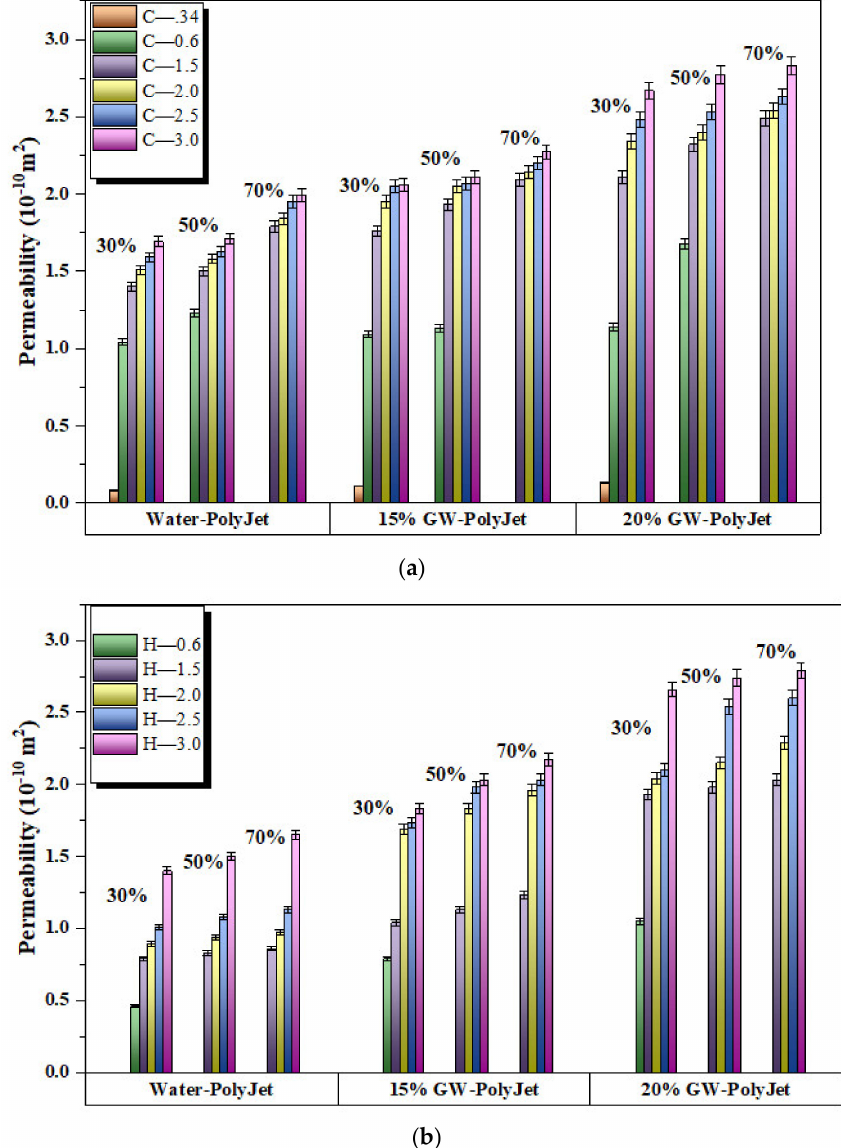
Figure 7. Experimentally measured permeability values for PolyJet 3D-printed scaffold structures using tap water, 15% glycerol–water solution, and 20% glycerol–water solution: ( a ) cubic structure; ( b ) hexagonal closed packed